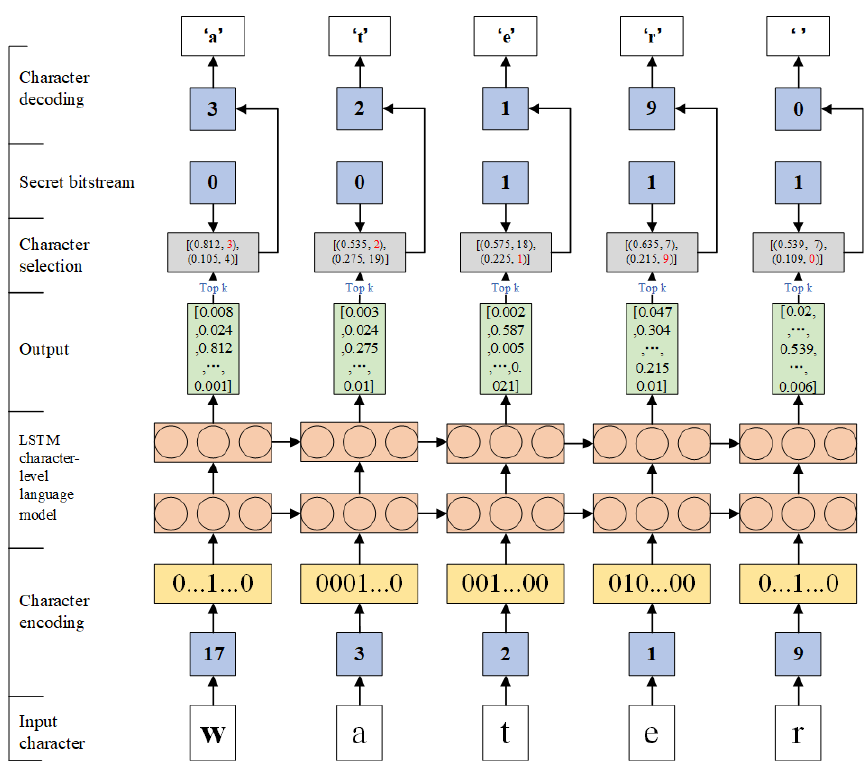
Figure 3. Architecture of the stego text generation based on the LSTM-character-level language model